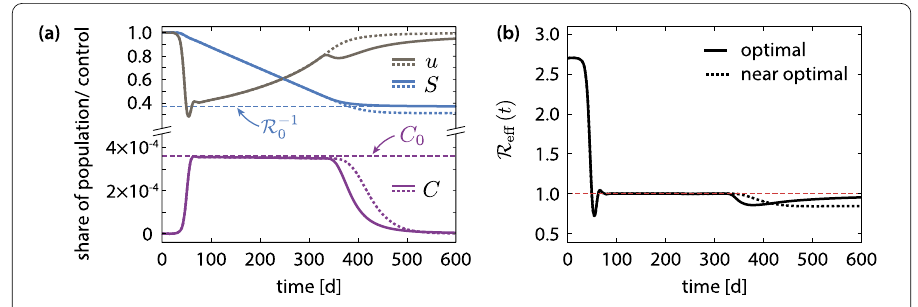
Figure 7 ( a ) Comparison of the optimal (dashed) and near optimal (dotted) control of the mean contact reduction. In the near optimal control, the strengthening of the measures in the final phase of the intervention is omitted. Instead, the near optimal control adheres to the stability boundary (14) and causes an overshoot of the susceptible population below the stability threshold ( S ( T ) < N ( T )/ R 0 ), ( b ) Plot of the corresponding effective reproduction